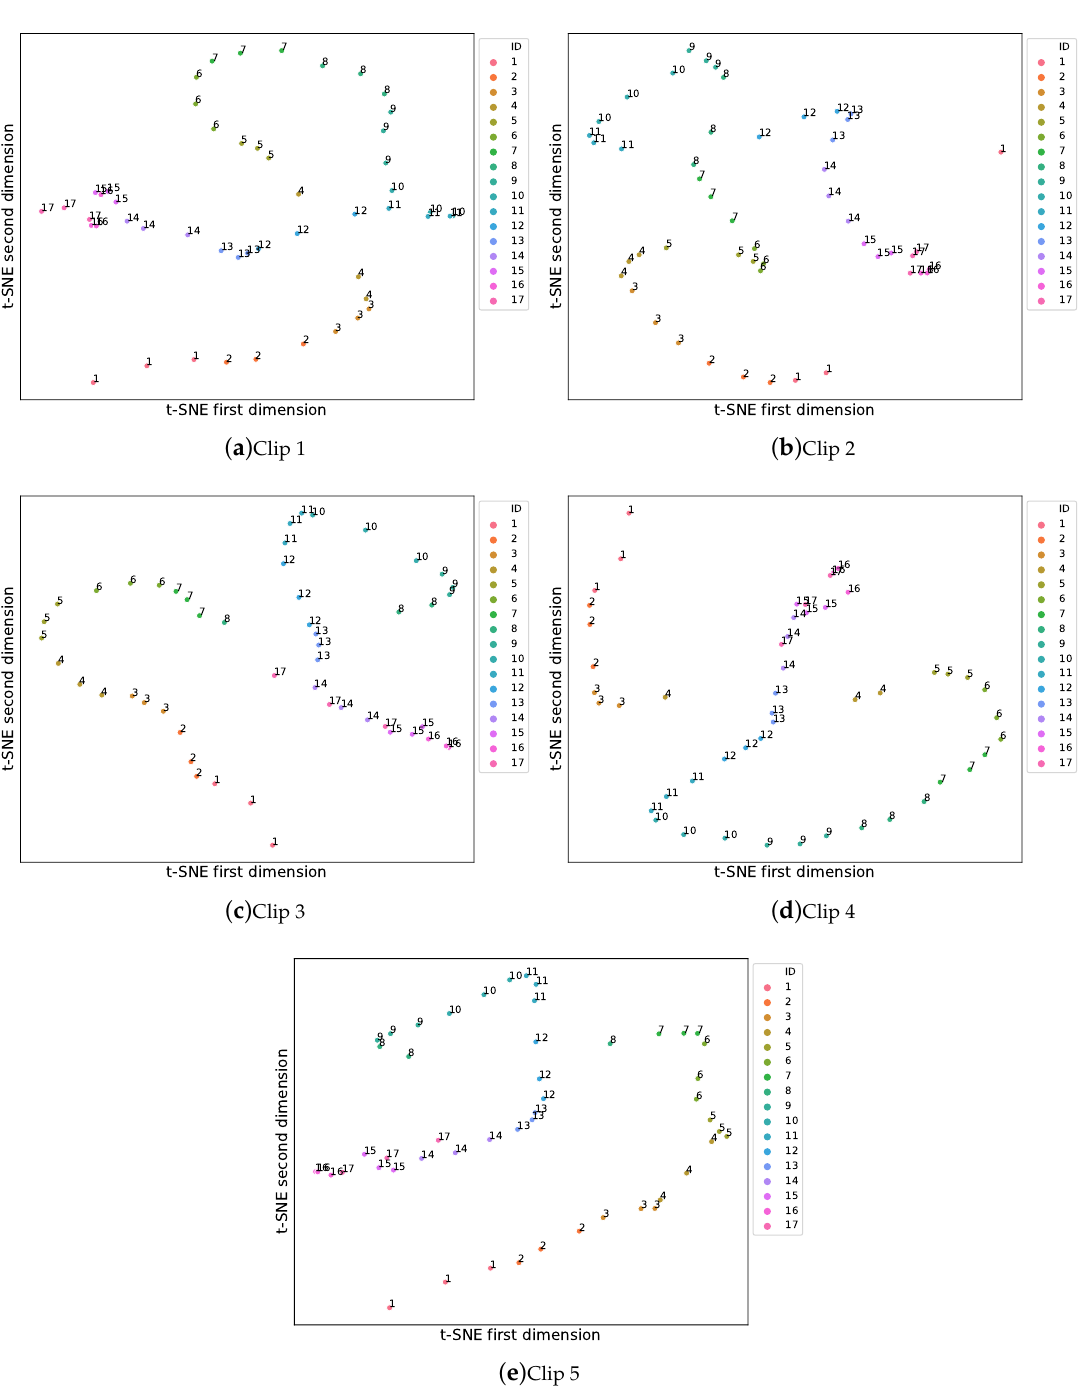
Figure 10. 2D t-SNE visualization for each of the five clips used as stimuli using the first 9 components of the SPCA projected data. The plots are obtained with a value of perplexity 35, early exaggeration 8, and learning rate